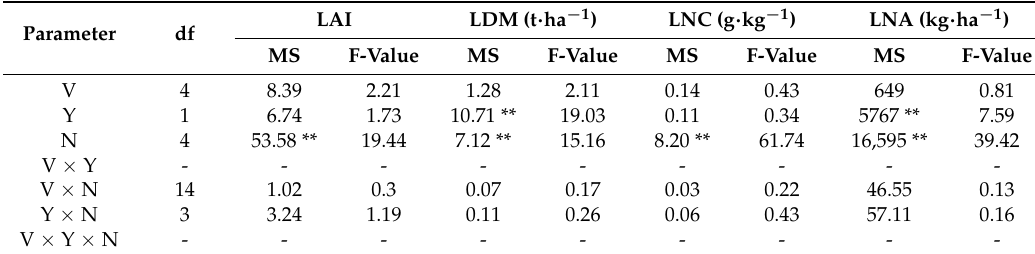
Table 3. Variance analysis of LAI, LDM, LNC, and LNA in different varieties (V), years (Y), and N rates (N). Table 4. Coefficient of determination between NDVI, RVI and wheat agronomic parameters at different stages in experimental fields across site-years.